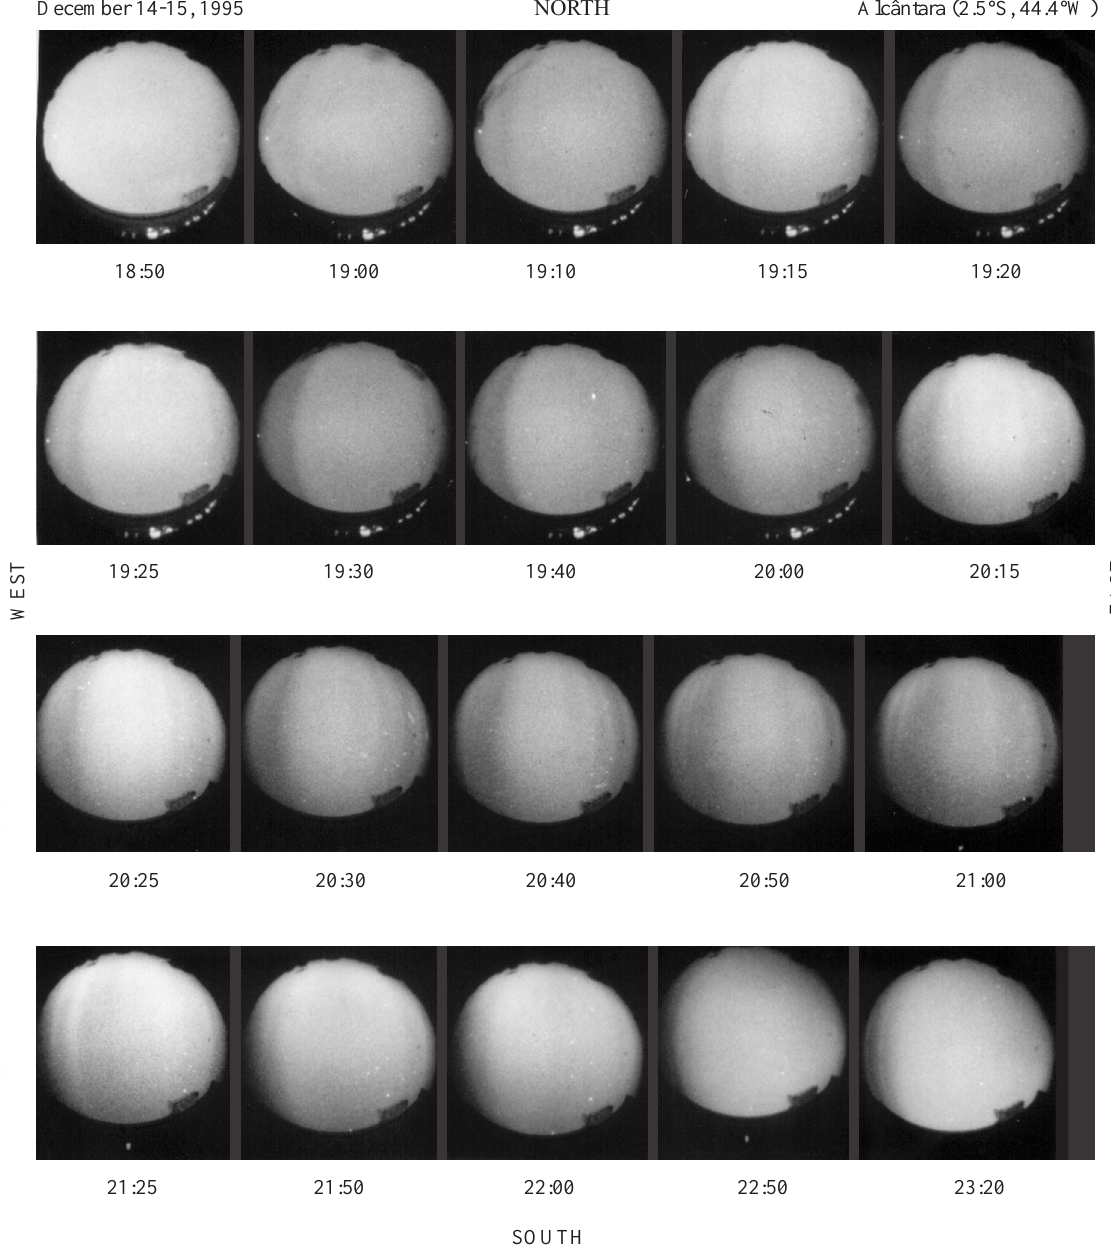
Fig. 2. Sequence of the OI 630 nm all-sky images obtained on December 14–15, 1995, at Alcaˆ ntara (2.5 (cid:176) S, 44.4 (cid:176) W),